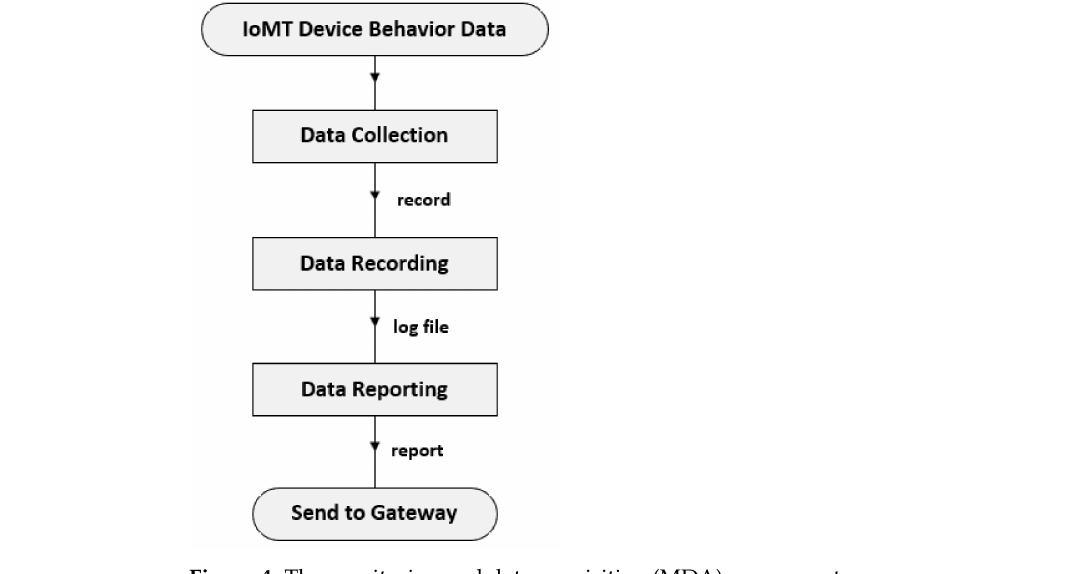
Figure 4. The monitoring and data acquisition (MDA) component.